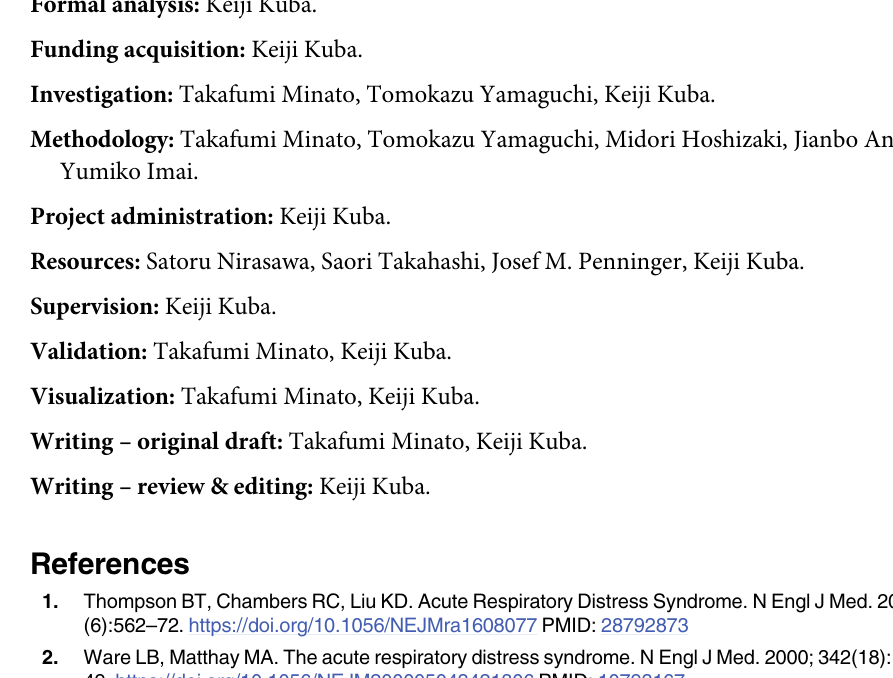
S1 Fig. Uncropped membranes of Western blot. A , Uncropped images of the blot in Fig 1A. B , Uncropped images of the blot in Fig 1C. S1 Table. qRT-PCR primers for cytokine mRNA